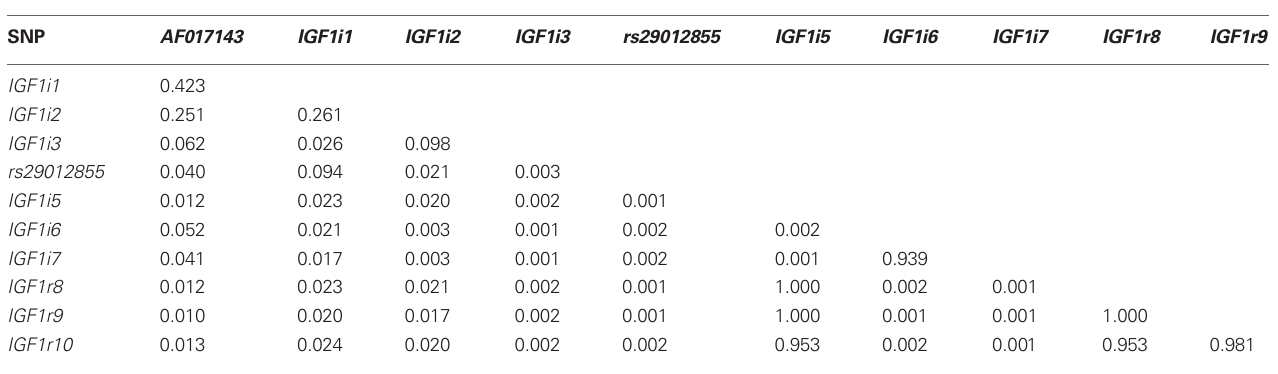
Table 4 | Linkage disequilibrium as measured by r 2 between the 11 segregating SNPs in this